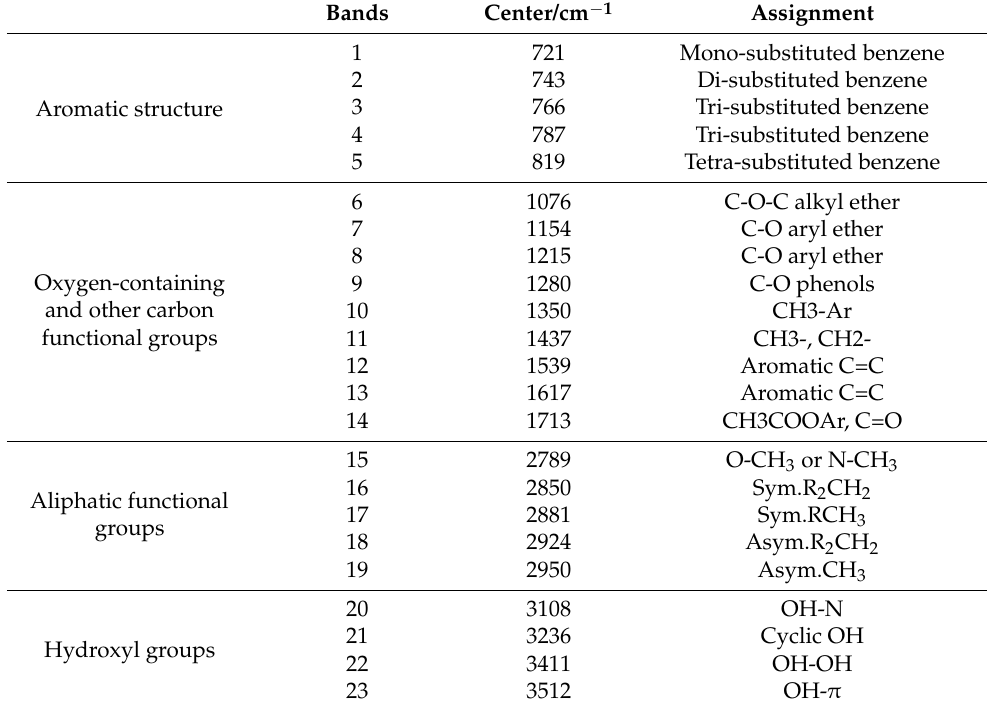
Figure 1. The FTIR spectrums of four sections: ( a ) aromatic structure; ( b ) oxygen-containing func- tional group; ( c ) aliphatic functional group; ( d ) hydroxyl group [60]. Table 1. Infrared bands belongings of the structures in lignite [60].